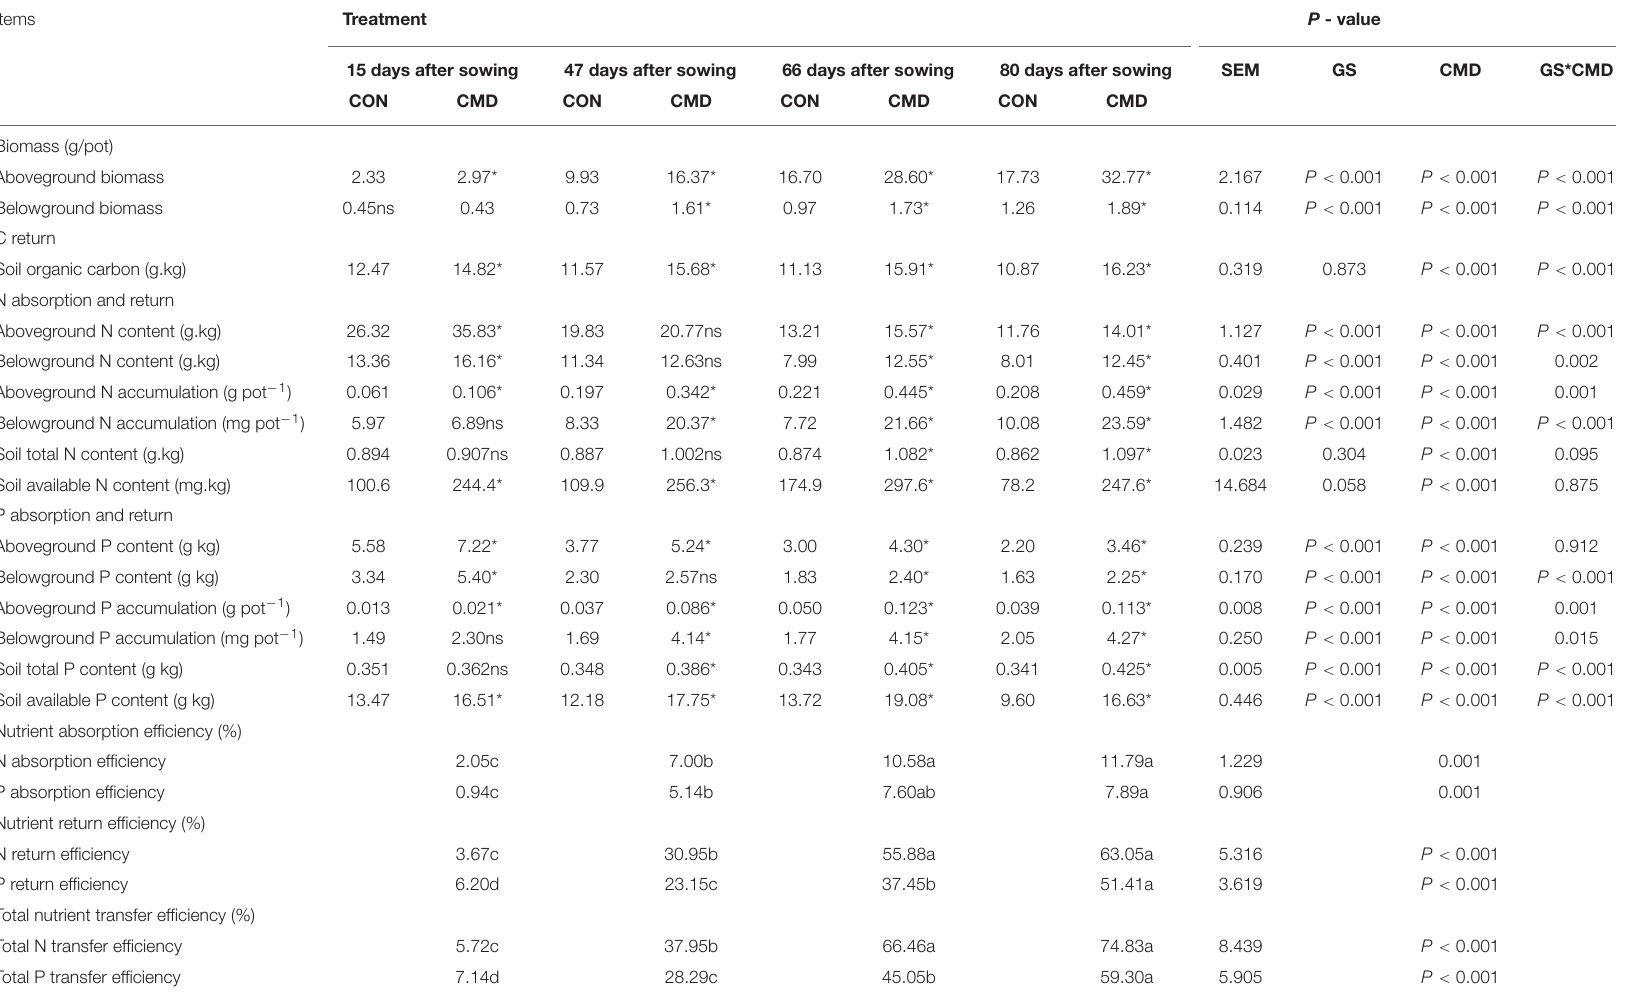
TABLE 1 | The dynamics of N and P transfer from cattle manure to soil and oats along plant growth stage under cattle manure